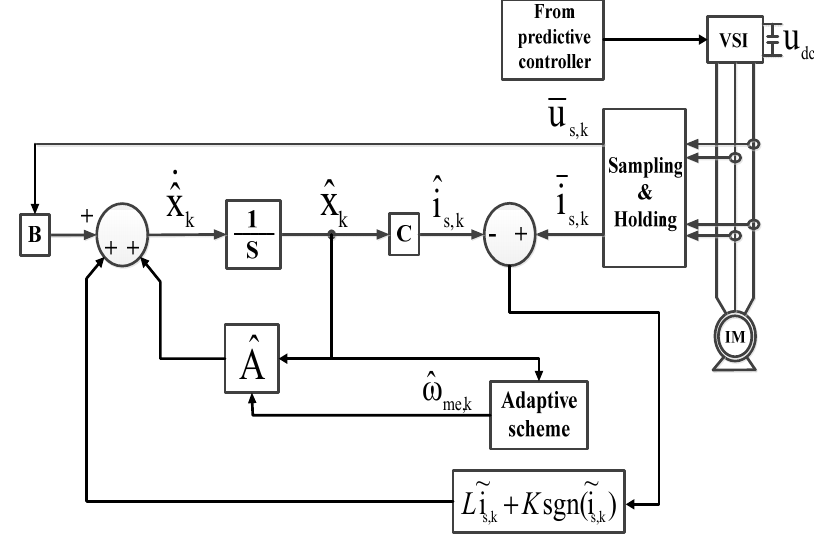
Figure 3. Proposed L-SMO observer system for IM drive.